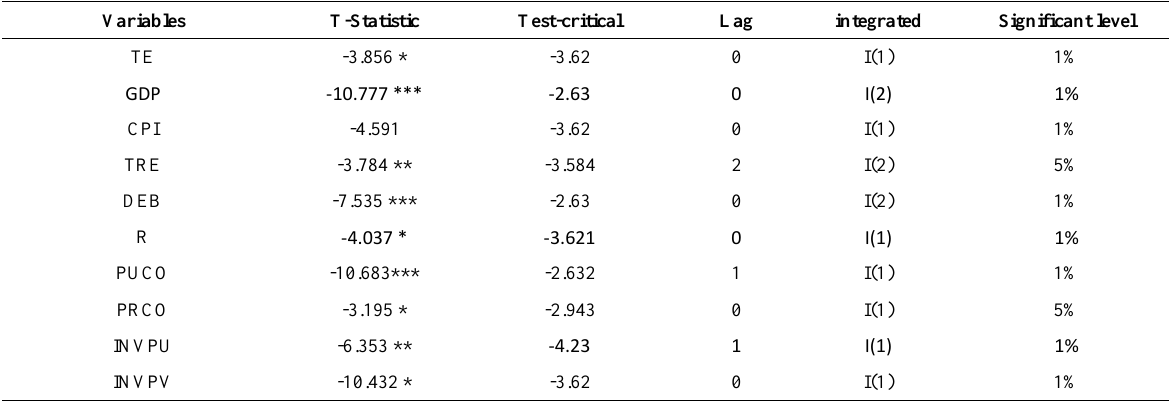
Table 5. Unit Root Tests.